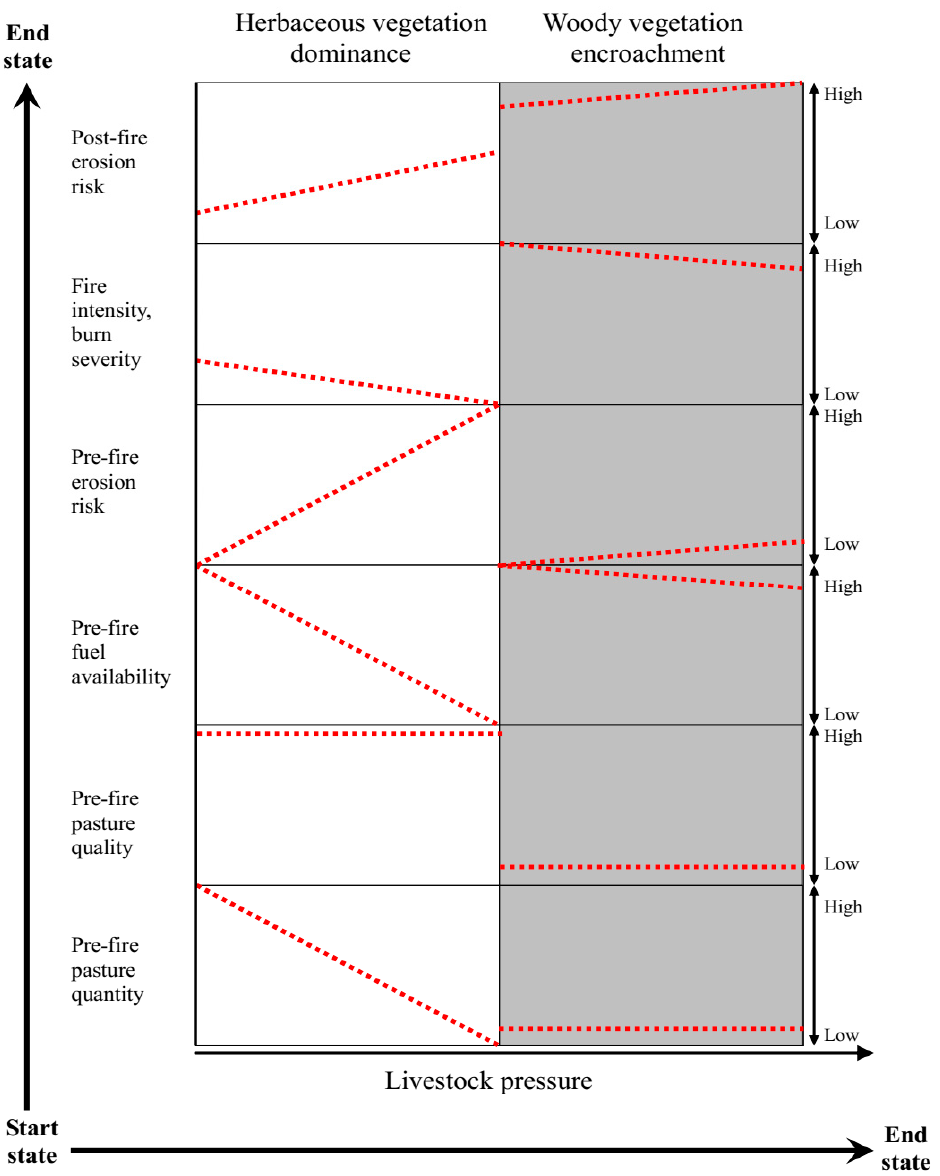
Figure 4. Conceptual illustration of the relative characteristics of grasslands and shrublands. Notes: In grasslands dominated by herbaceous vegetation, aboveground biomass is maximal, but decreases with an increase in livestock pressure. The pasture quality of these lands is high. The increase in livestock pressure reduces the available fuel, and at the same time, increases the risk of erosion. In the event of wildfires, the increase in livestock pressure decreases the fire intensity and burn severity, and at the same time, increases the erosion risk. Under pre-fire conditions, the increase in livestock pressure allows the encroachment of woody vegetation, which is characterized by low quantity and quality of pasture. At the same time, the high quantities of aboveground biomass of these ecosystems provide high quantities of fuel, but this is moderately controlled by livestock pressure. The soil erosion risk of these ecosystems is rather low, but slightly increases with increasing livestock